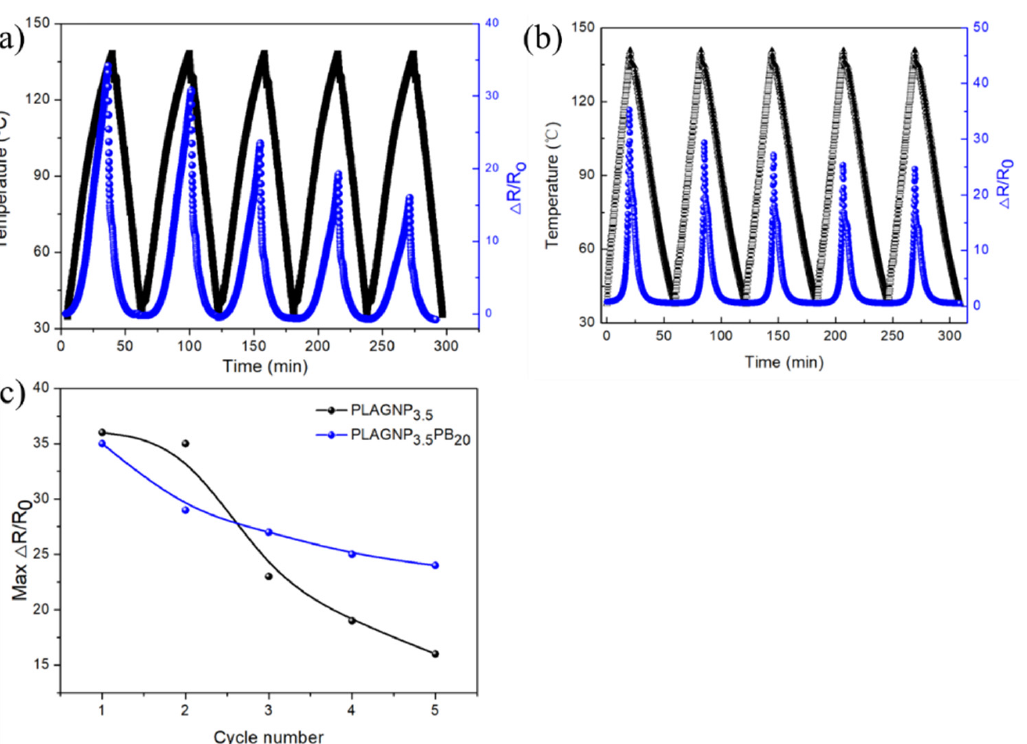
Figure 7. The electrical conductivity versus temperature curves of ( a ) PLAGNP 3.5 , ( b ) PLAGNP 3.5 PB 20 and ( c ) the changes of max ∆ R/R 0